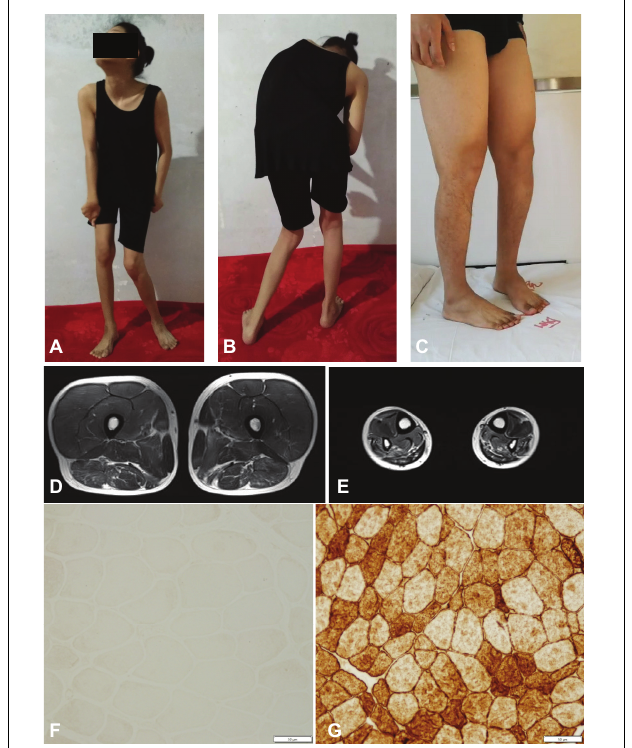
FIGURE 2 | Clinical features of the familial member II-1 and II-2. (A,B) Photographs of the familial member II-2 showing clinical features of generalized dystonia. (C) Photograph of the familial member II-1 showing muscle atrophy in both distal lower limbs. (D,E) MRI revealed normal proximal muscle in the lower extremities and atrophy of the distal limbs in the familial member II-1. (F) Immunostaining of muscle biopsy of the familial member II-1 demonstrated absence of Dysferlin (Bar, 50 µ m). (G) Immunostaining of muscle biopsy of a healthy volunteer showed normal Dysferlin staining (Bar, 50 µ